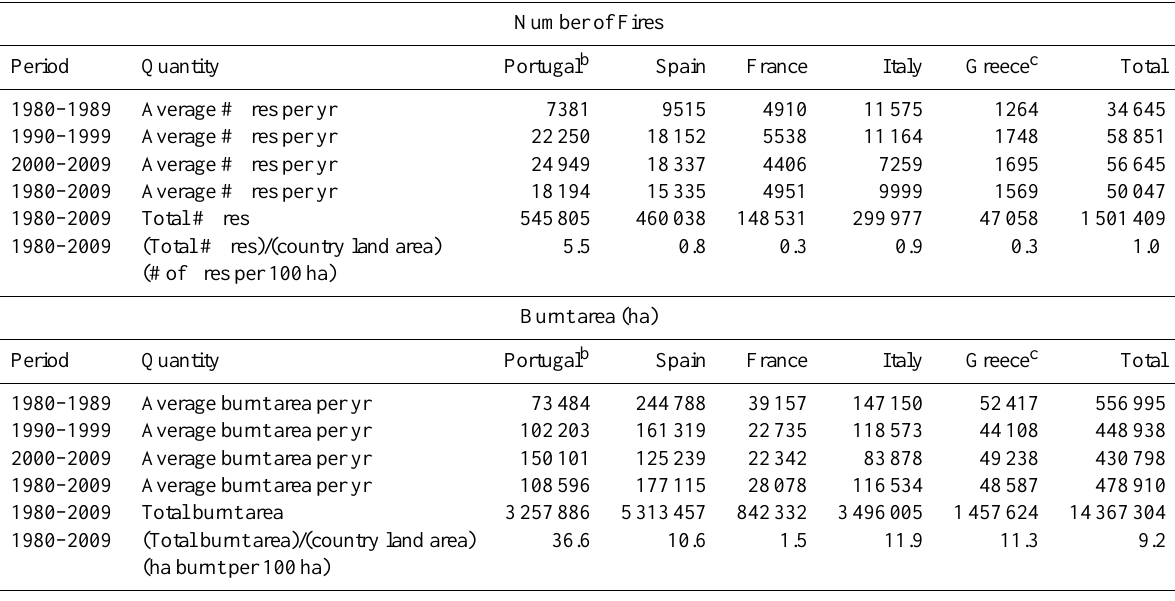
a Table does not include information about the completeness of the data (i.e. different countries or administrative areas within each country may not include fires below a given burnt area). b The country land area used here for Portugal is 91500km 2 , as the statistics here are based on all of Continental Portugal (vs. just mainland Portugal). c Provisional data for